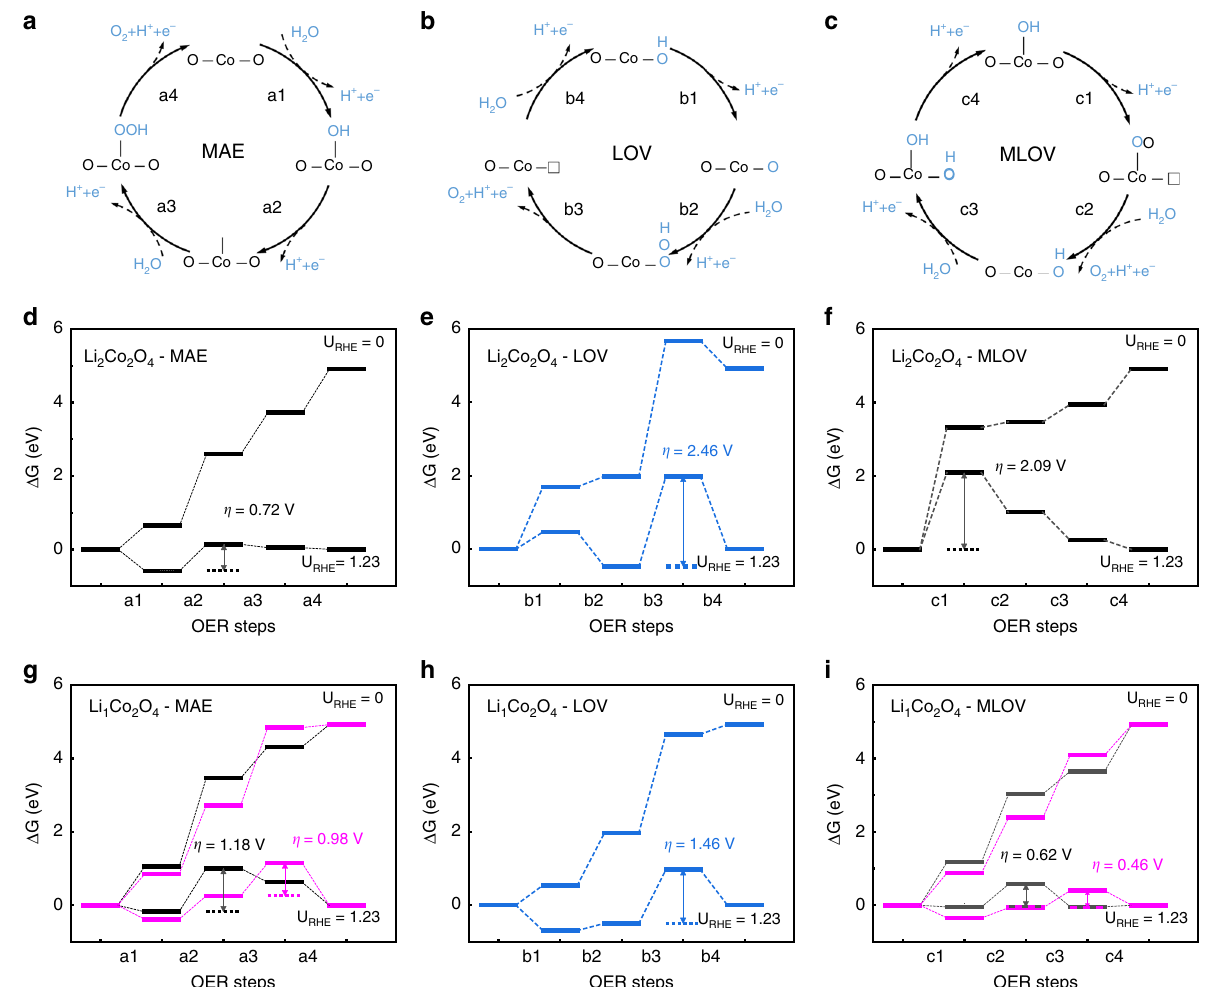
Fig. 5 Schematic OER mechanisms involving four concerted proton – electron transfer steps. a , d , g MAE: this is a conventional OER mechanism, in which adsorbates are located at the transition-metal site. b , e , h LOV: in this scenario, adsorbates are only located at the site of the lattice-oxygen vacancy generated during redox reactions. c , f , i MLOV: in this scenario, adsorbates are located at both the transition-metal site and the oxygen vacancy site. The free energies under different potentials U RHE for the OER on Li 2 Co 2 O 4 in d – f and Li 1 Co 2 O 4 in g – i . The black lines and the magenta lines indicate the Co 3 + site and Co 4 + site, spin (HS) state for the t 2 g 4 e g 2 con fi guration is well documented (UHB), as shown in Supplementary Fig. 11) decreases with increasing valence state of the TM ion 47 . For Co 2 + , it is positive 48,49 ; for Co 3 + , it is close to zero 50 ; and for Co 4 + , it can be negative 27,28,51 . Consequently, the covalency increases, i.e., from rather ionic for Co 2 + , to highly covalent for Co 3 + , and further to Co 4 + , in which the holes mainly reside on the oxygen ligands rather than on the Co 27,28 . This trend can experimentally be directly observed in the O – K SXAS spectra: Supplementary Fig. 6 shows the spectral changes upon converting CoO to the as- prepared Li 2 Co 2 O 4 , Li x CoO 2 , and Li 2 Co 2 O 4 after the OER and fi nally to BaCoO fi gure displays how the spectral weight is 3 . The shifting quickly to lower energies with increasing valence. The schematic density of states of Co 3 + and Co 4 + oxides (in the limit of no metal-ligand hybridization) is also shown in Supplementary Fig. 11 for Co 3 + and Co 4 + oxides. The relation between the charge-transfer energies Δ 4 + and Δ 3 + is Δ 4 + = Δ 3 + − U + δ , where U is the on-site Co 3 d Coulomb repulsion and δ is an extra gain originating from the lattice relaxation. It was previously found that the shift of the valence band center toward E f upon converting Co 2 + /Co 3 + to the mixed Co 3 + /Co 4 + oxide can easily facilitate the formation of O – O 5,13,40,52,53 .